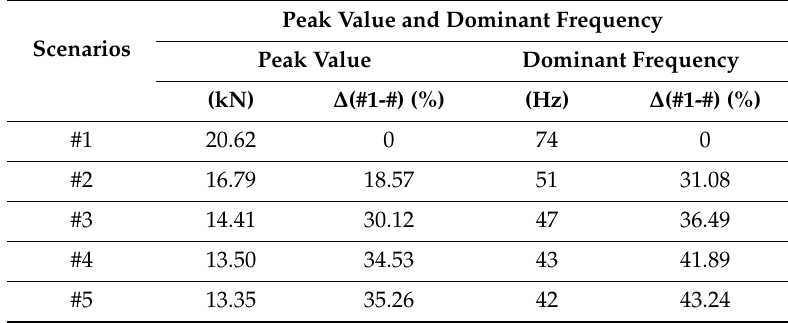
Table 5. The peak value and dominant frequency from the vertical acceleration of the wheelset.